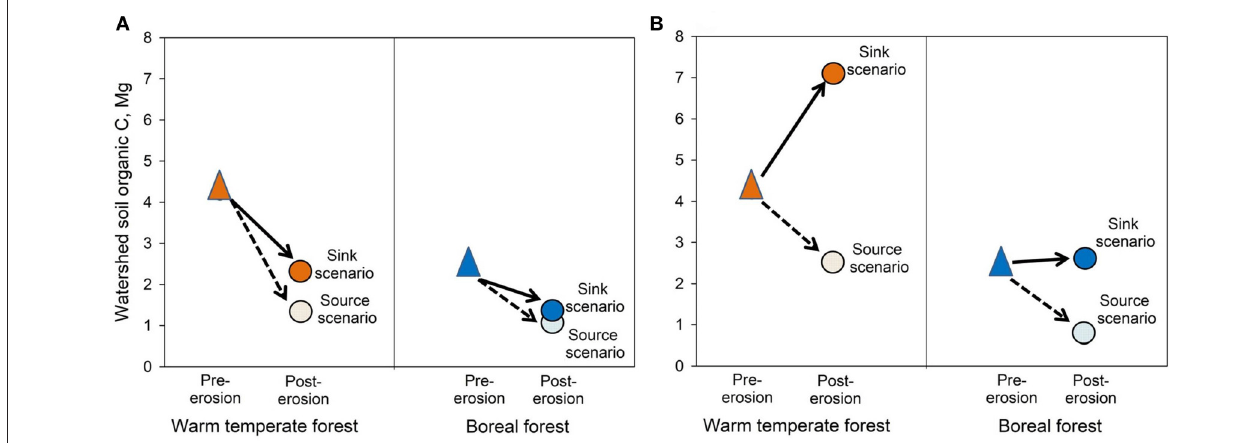
FIGURE 6 | Model estimates of soil organic C prior to the onset of modeled erosion (triangle in all panels), and after 100 y of erosion (post-erosion points in all panels) for two erosion rates: (A) 0.1mm y − 1 and (B) 1mm y − 1 in a warm temperate forest watershed and a boreal forest watershed, assuming that 90% of the watersheds experiences erosion and 10% experiences deposition. Values reflect watershed sizes of 638 and 345 ha for the warm temperate and boreal forests, respectively. The sink or source scenario terms refer to model runs generating the maximum possible CO 2 sink or source terms. Maximum sink scenario assumes maximized SOC production and minimized SOC oxidation; maximum source scenario assumes minimized SOC production and maximized SOC oxidation in both eroding and depositional settings. Differences between the warm temperate and boreal forest are most pronounced at high erosion rates (B) . Note that at low erosion rates (A) , even when the sink strength is maximized the SOC content post-erosion is lower than the pre-erosion content in both forests, and thus this scenario does not represent a true sink, but rather a smaller CO 2 source (i.e., greater SOC content relative to the maximum source